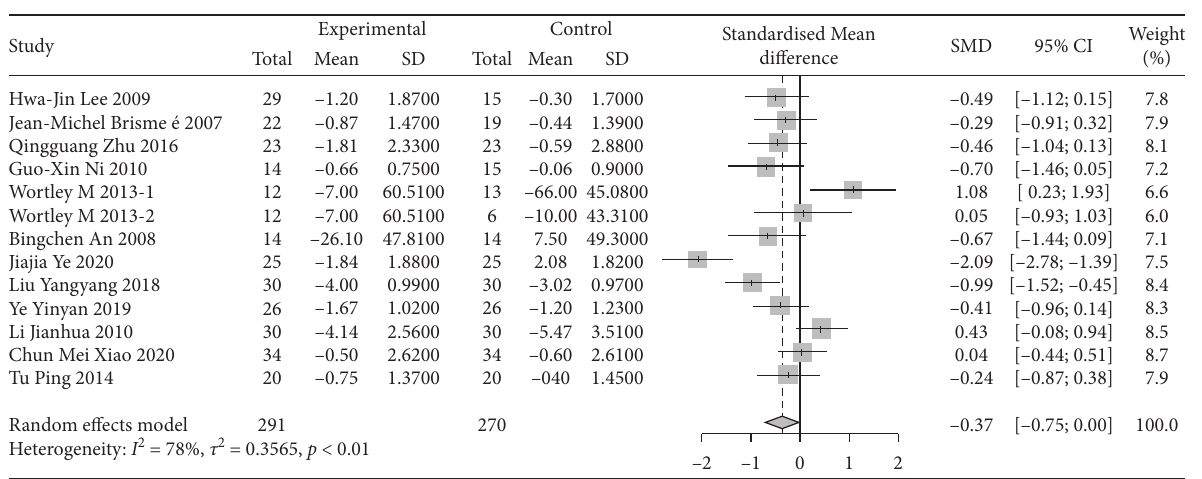
Figure 8: Meta-analysis of WOMAC stiffness comparison between the traditional Chinese exercise group and the control group.